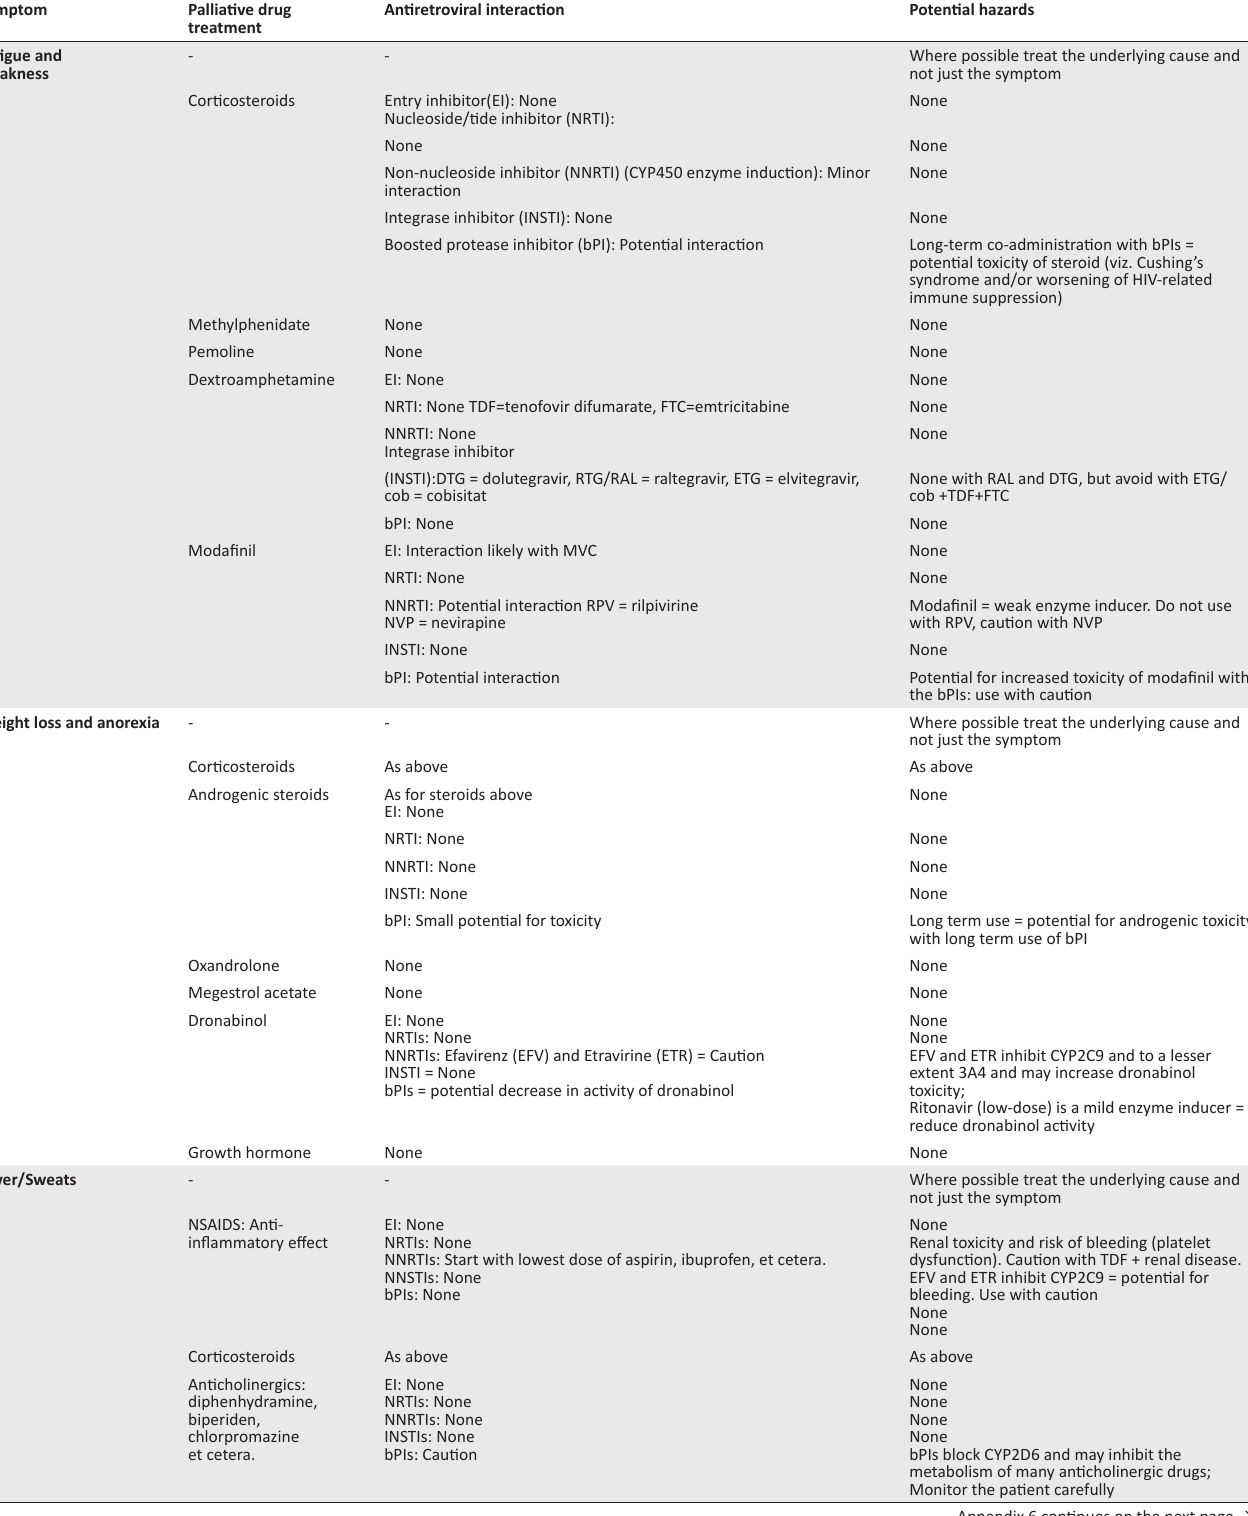
TABLE 1-A6: Palliative care management, drug–drug interactions. Symptom Palliative drug Antiretroviral interaction Potential hazards treatment Fatigue and